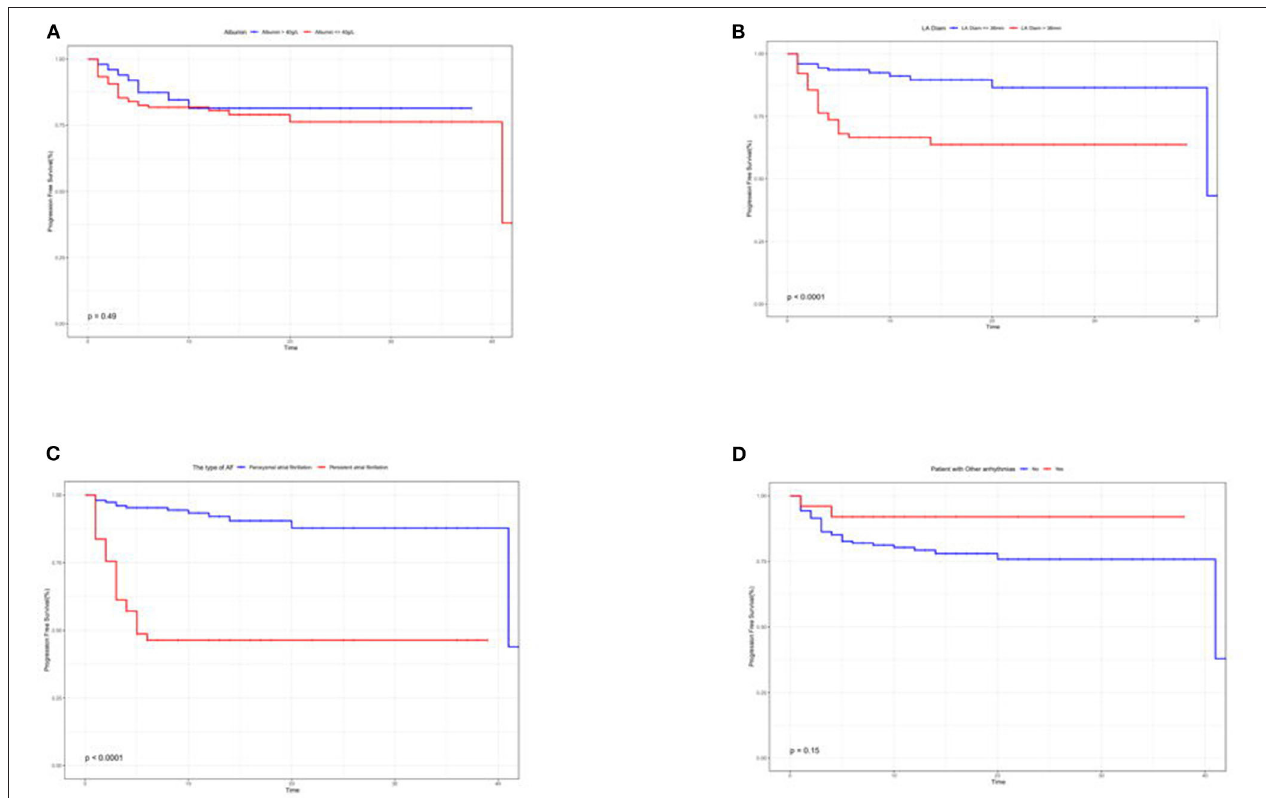
FIGURE 4 | (A–D) Kaplan–Meier survival curves to assess the impact of albumin (A) , left atrial diameter (B) , type of Af (C) , and whether other arrhythmias combined (D) on the recurrence prognosis of patients.